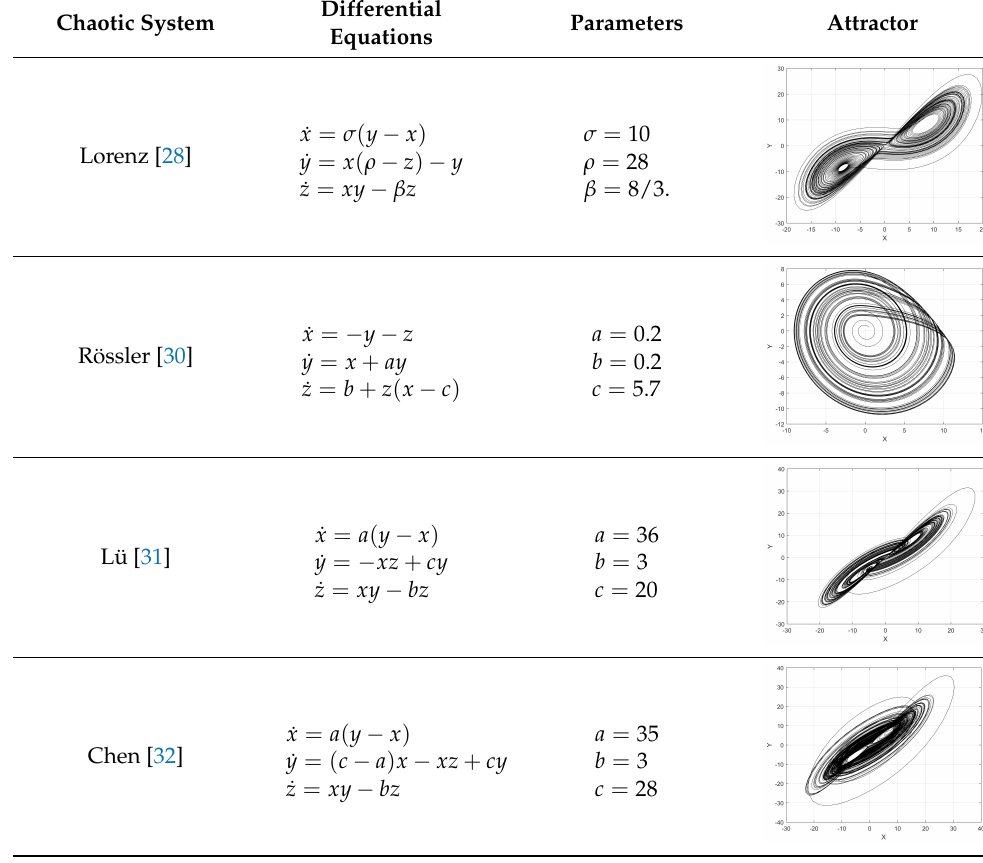
Table 1. Classic Chaotic